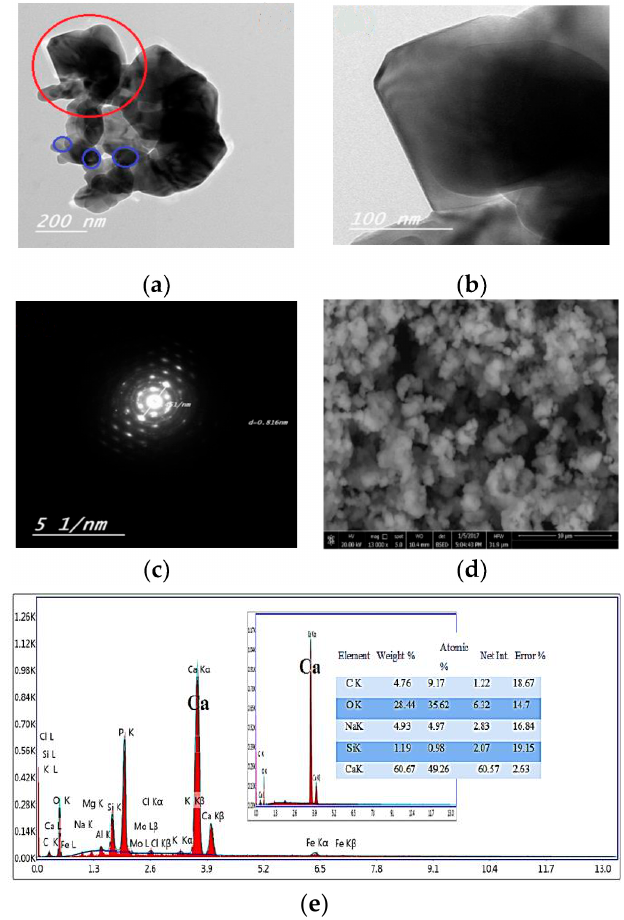
Figure 1. ( a,b ) TEM images of CMW with different magnification, ( c ) selected area electron diffraction (SAED) pattern for CMW, ( d ) SEM of CMW, and ( e ) EDX chart of CMW before and after calcination.